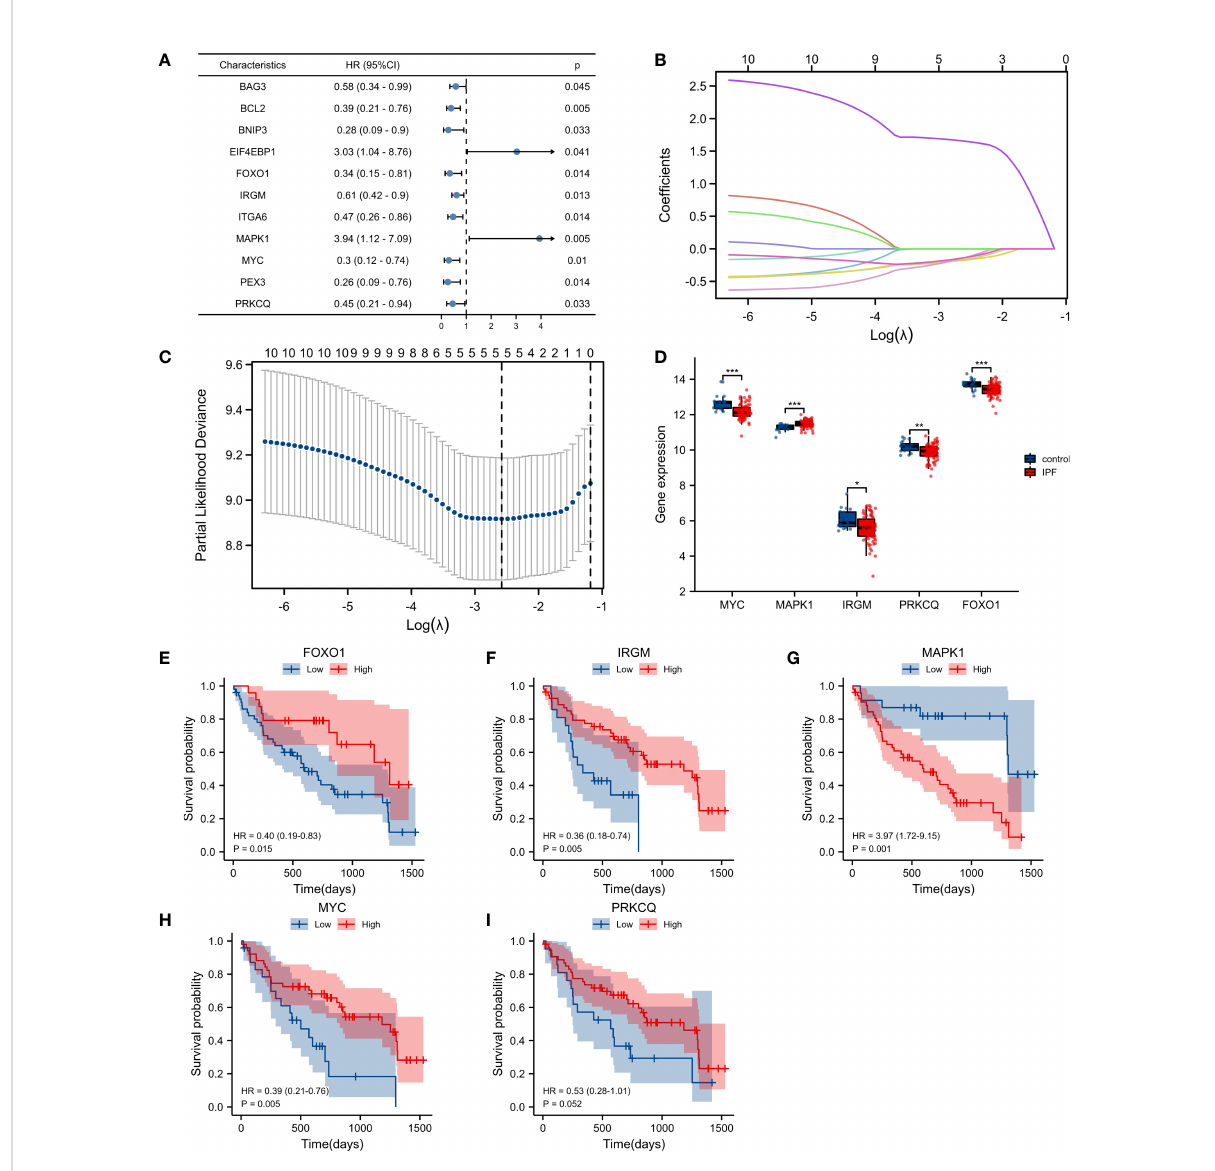
FIGURE 2 Construction of the autophagy-associated prognostic model. (A) Univariate Cox analysis identi fi ed genes related to the prognosis of IPF patients. (B, C) Screening of characteristic genes by LASSO regression analysis. (D) Differences of fi ve genes in GSE28042. (E – I) Survival analysis of FOXO1, IRGM, MAPK1, MYC , and PRKCQ . *p< 0.05, **p< 0.01, and ***p<